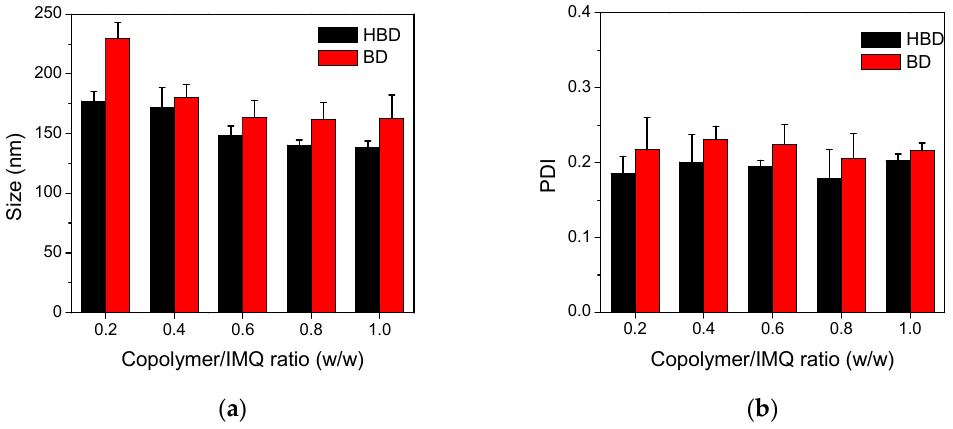
Figure 5. ( a ) Particle size and ( b ) PDI for of BD and HBD nanoparticles prepared from various copolymer/IMQ feed ratios.